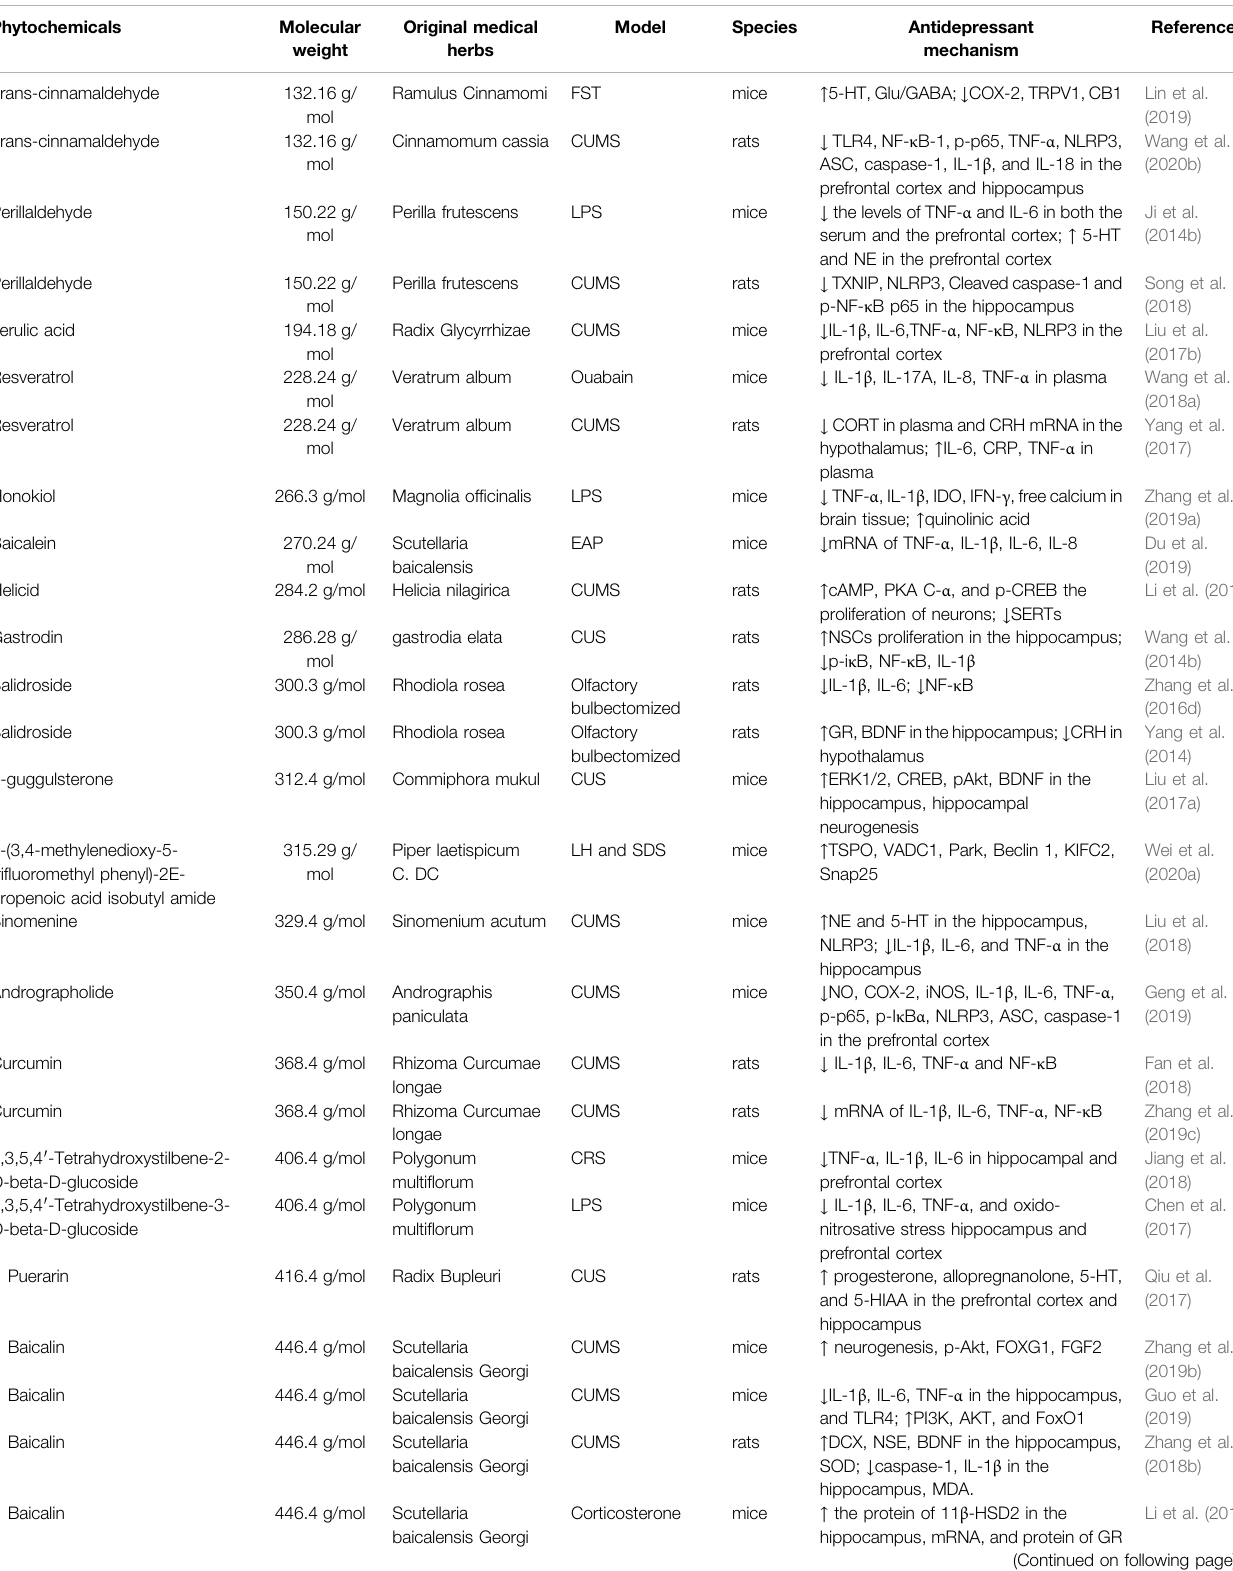
TABLE 4 | Antidepressant mechanism of